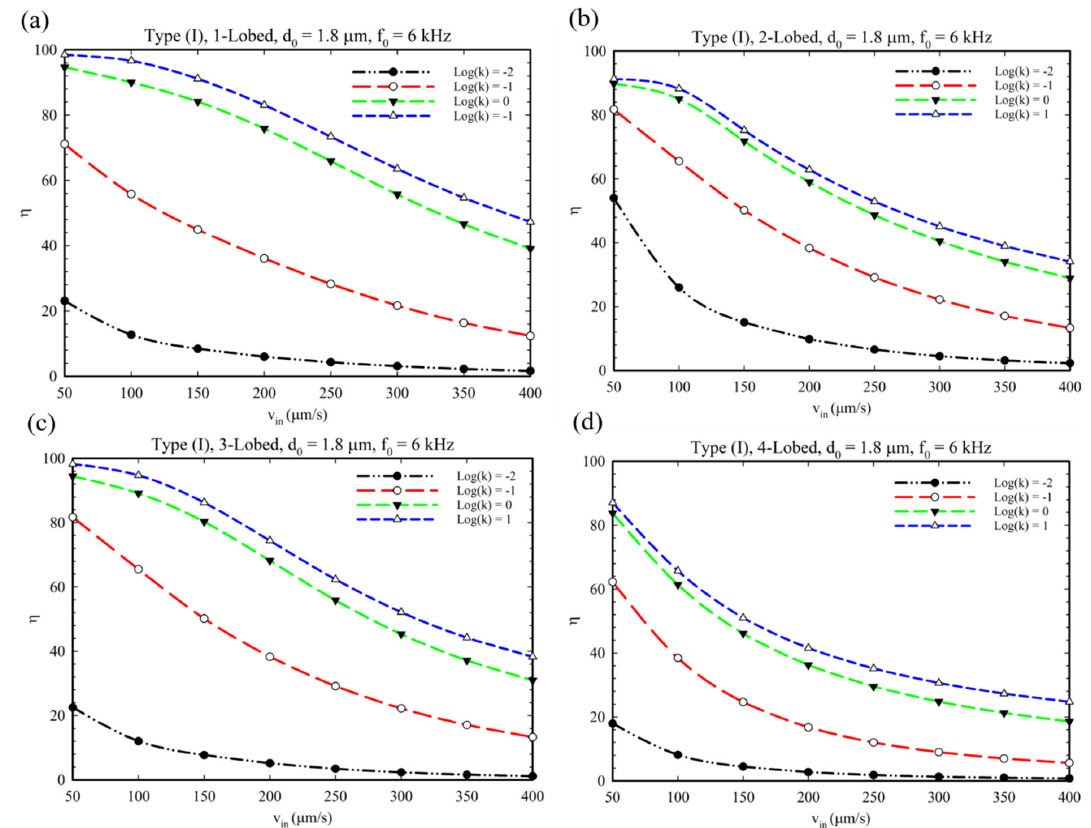
Figure 10. The reaction yield for chemical reaction at different fluid velocities for different multi ‐ lobed structures and Type I configuration. ( a – d ) One to four ‐ lobed structures.